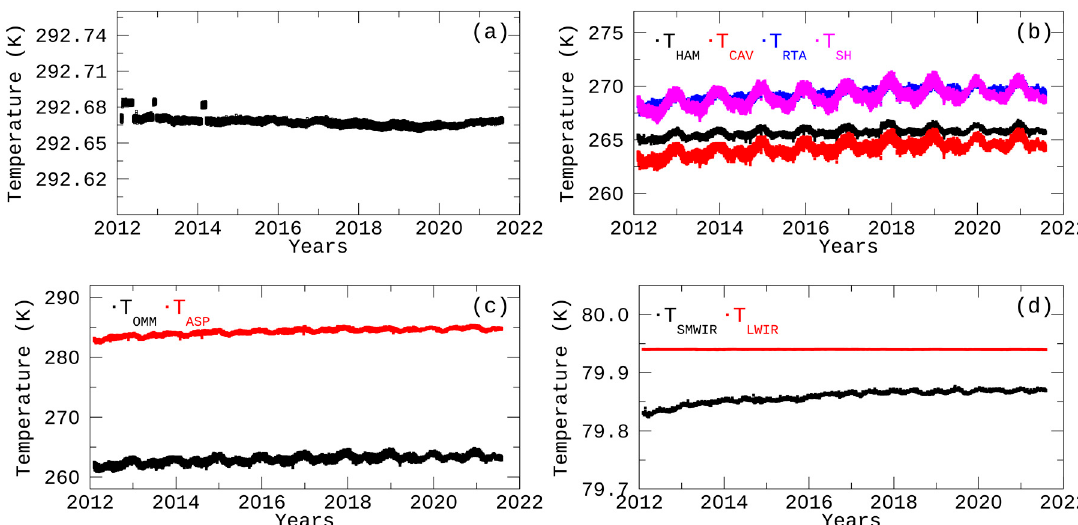
Figure 4. S-NPP VIIRS ( a ) BB temperature; ( b ) inputs to the thermal model: HAM, RTA, scan cavity (CAV), and BB shield (SH) temperatures; ( c ) electronics (ASP) and instrument opto-mech module (OMM) temperatures; and ( d ) cold FPAs temperatures over the entire mission. Values are daily-averaged.